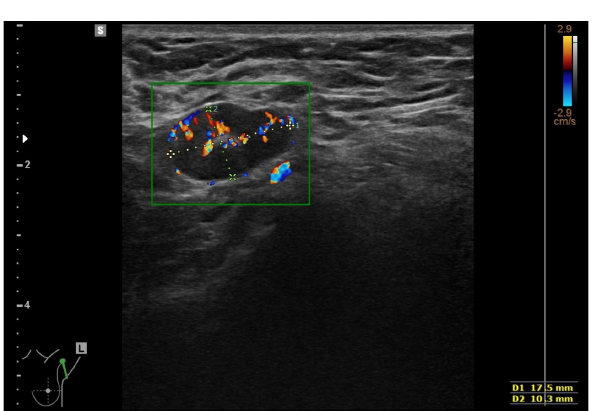
Fig. 1. Lymph node with hypoechoic diffuse cortex thickening and peripheral vascularization.